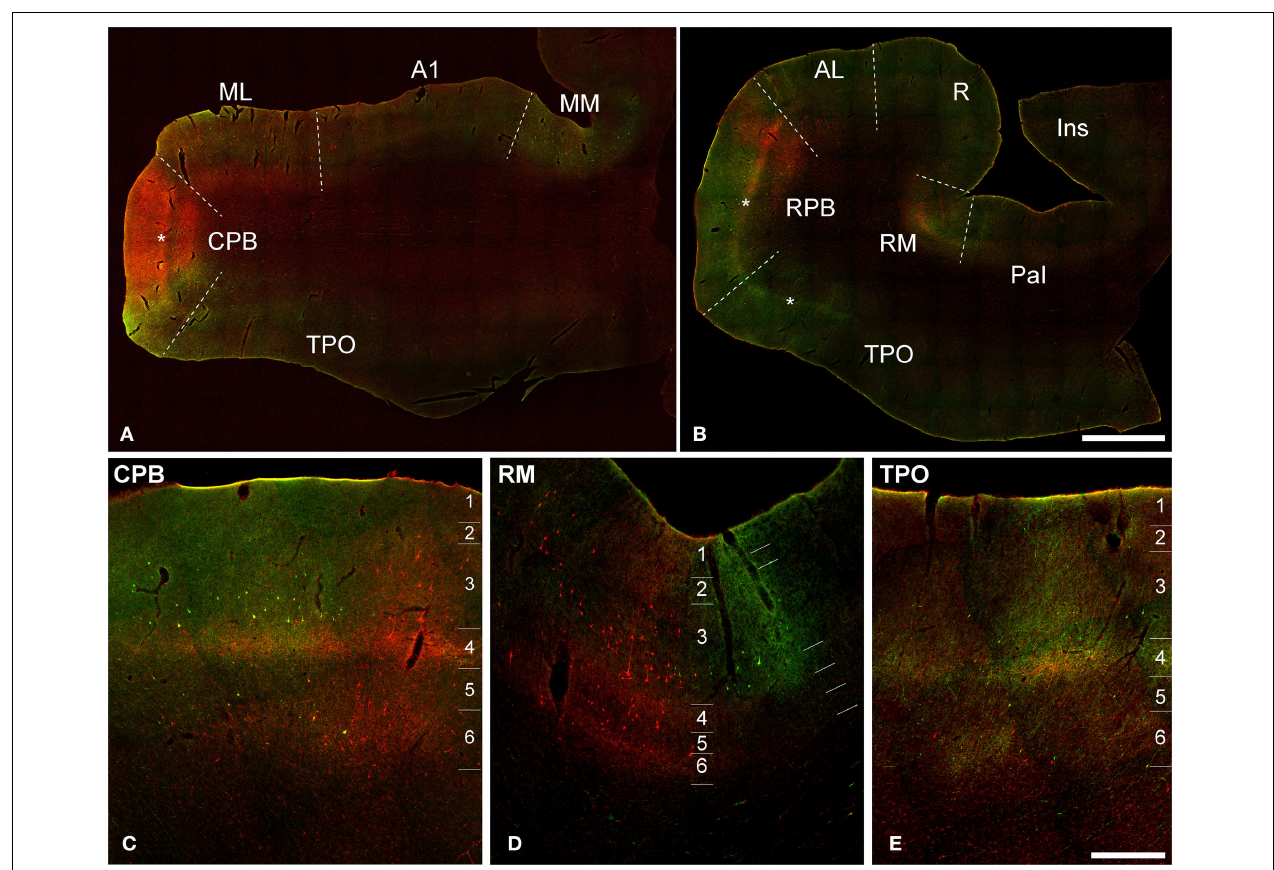
FIGURE 3 | Dual fluorescence images of BDA (green) and FR (red) labeling of axons, terminals, and somata in Case 2. (A,B) Low magnification sections from caudal (A) and rostral (B) sections. Asterisks denote position of layer 4. (C–E) Higher magnification views through